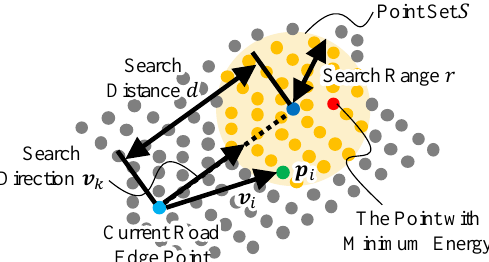
Figure 7. Road edge extraction by tracking of road edge points. Cyan point is a current road edge point. Blue point calculated by the current road edge point and search direction with search distance is a reference position of a search range. Orange points are point clouds within the search range from the blue point. Green point is the one in the point set. Red point is the point with the minimum energy in the point set and is considered the road edge point.